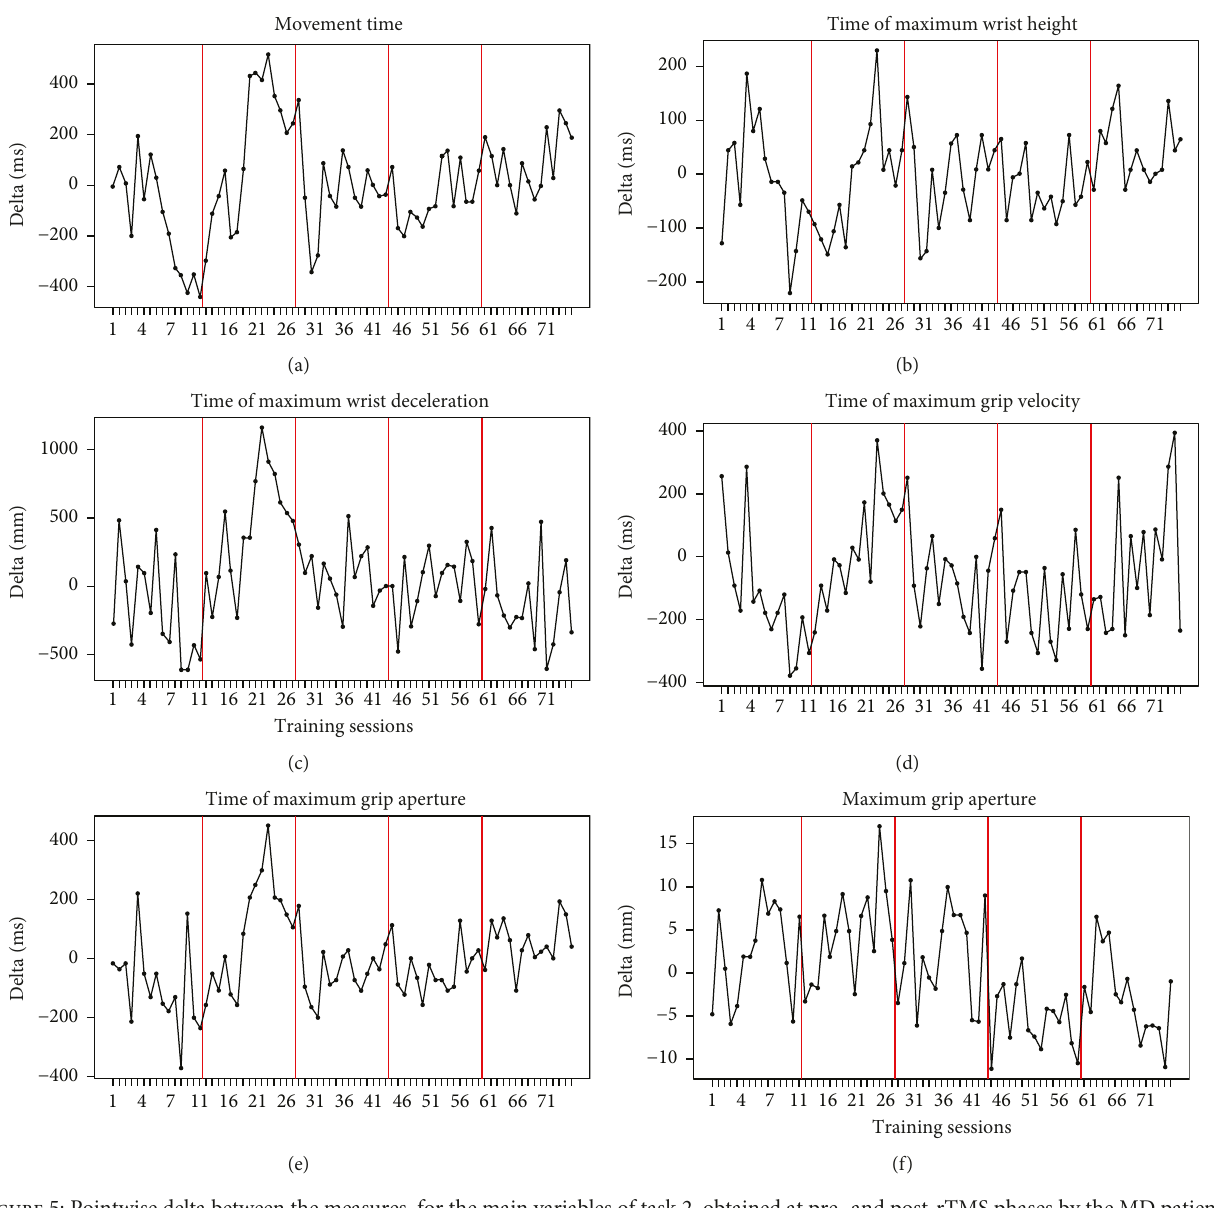
Figure 5: Pointwise delta between the measures, for the main variables of task 2, obtained at pre- and post-rTMS phases by the MD patient. Parameters referring to the reaching component are listed on (a), (b), and (c), whereas parameters for the grasping component are displayed on (d), (e), and